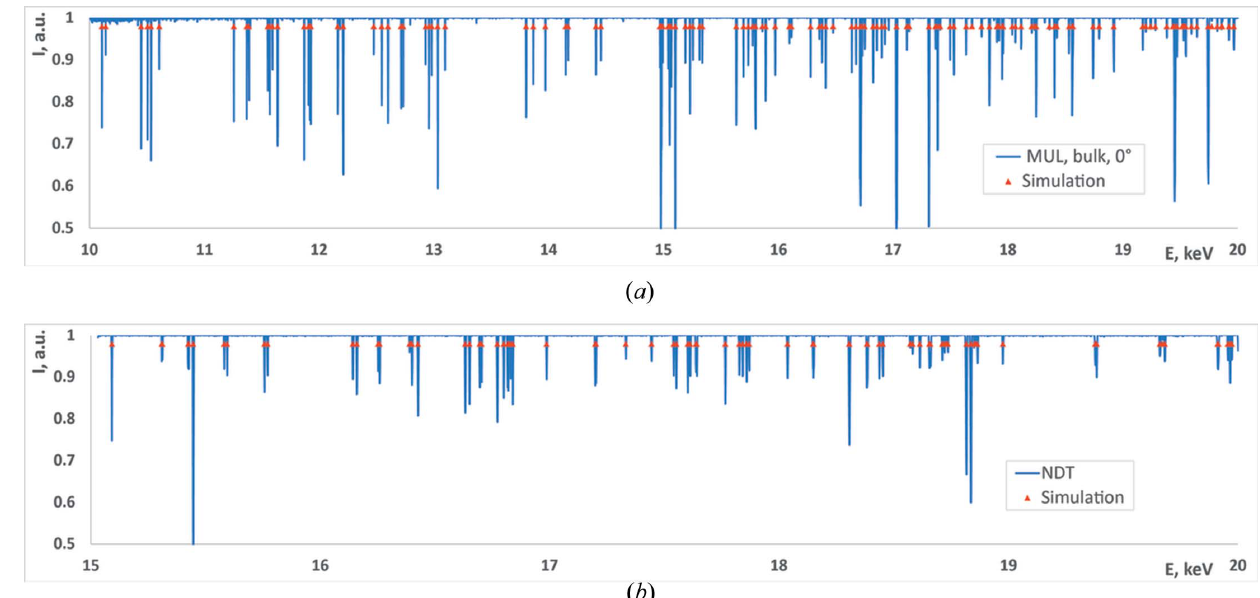
Figure 4 Spectra of measured glitches (blue curves) overlapped with the calculated spectra (red triangles) for two 1D lenses: ( a ) MUL and ( b ) NDT.